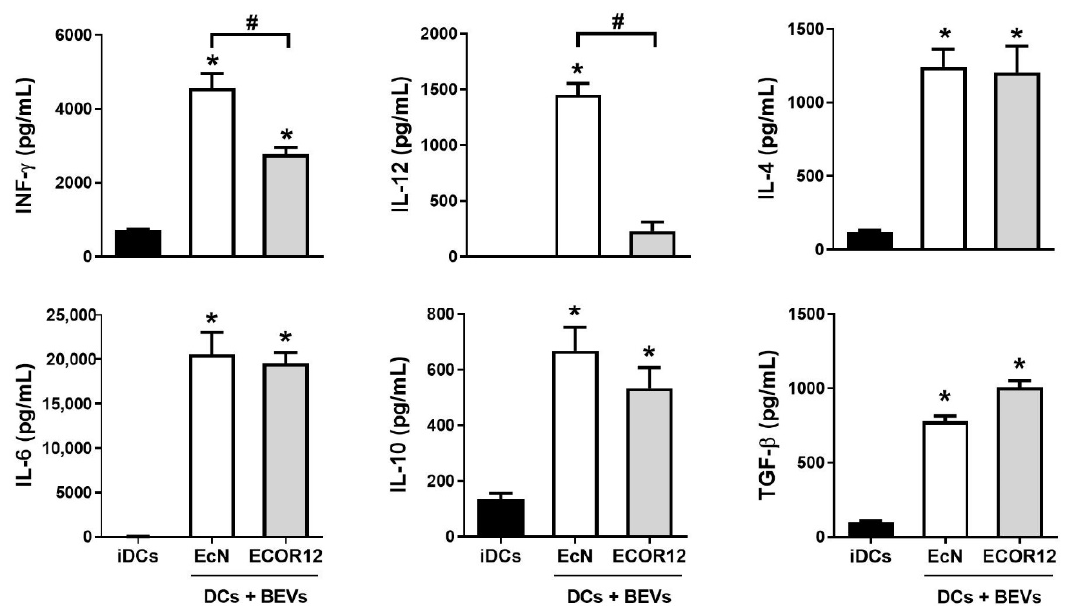
Figure 1. Activation of mo-DCs by BEVs from the probiotic EcN and the commensal ECOR12. Levels of INF- Υ , IL-12, IL-4, IL-6, IL-10, and TGF- β secreted by mo-DCs were quantified after 6 h incubation with BEVs (10 µ g/mL) of the indicated strains. Untreated mo-DCs (iDCs) were used as a control (black bars). Data (mean ± SEM) are from three independent biological experiments (at least six donors) performed in triplicate. Statistical differences were assessed by one-way ANOVA followed by Tukey’s test ( p < 0.05). * Significance versus untreated control DCs, # significance between DCs stimulated with EcN or ECOR12 BEVs.